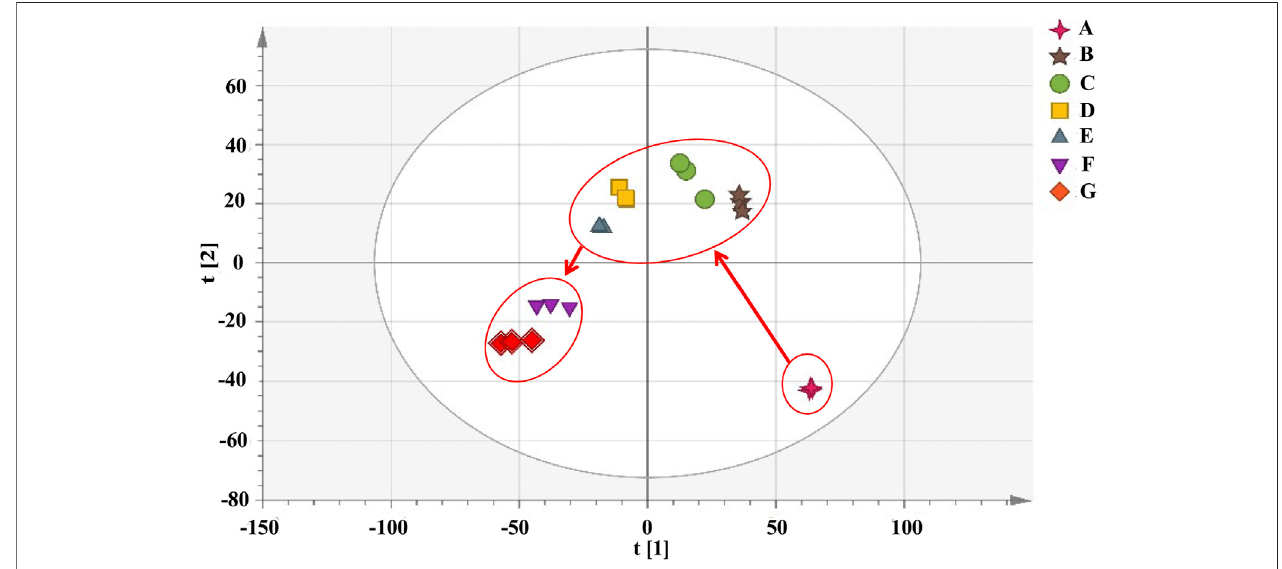
FIGURE 3 | The score plots of PCA model for samples of Reynoutria multi fl ora with different processing times analysis. R2X and Q2 values of the PCA model are 0.953 and 0.871, respectively. (A) : raw Reynoutria multi fl ora (RRM), (B) : processed Reynoutria multi fl ora (PRM) 4 h, (C) : PRM 8 h, (D) : PRM 12 h, (E) : PRM 18 h, (F) : PRM 24 h, (G) : PRM 32